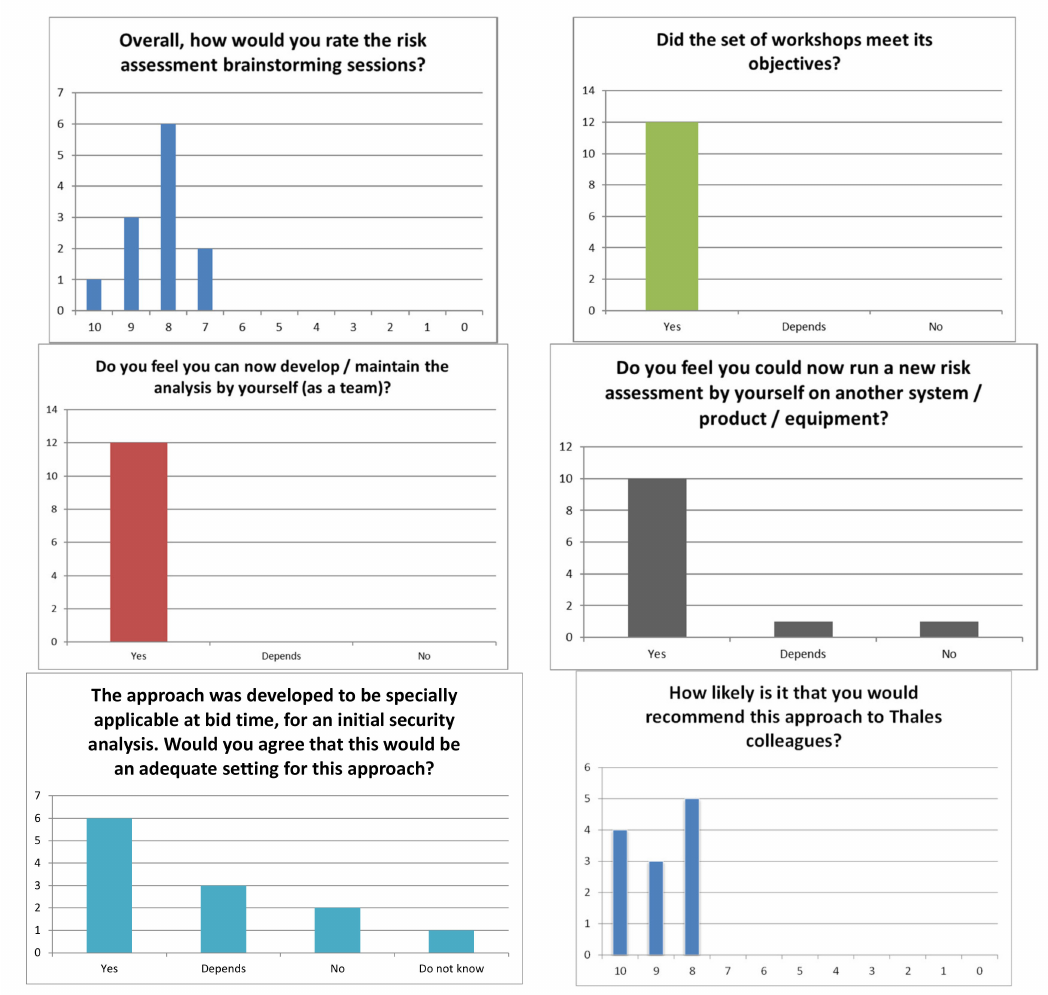
Figure 1. Extract of railway signalling use case survey